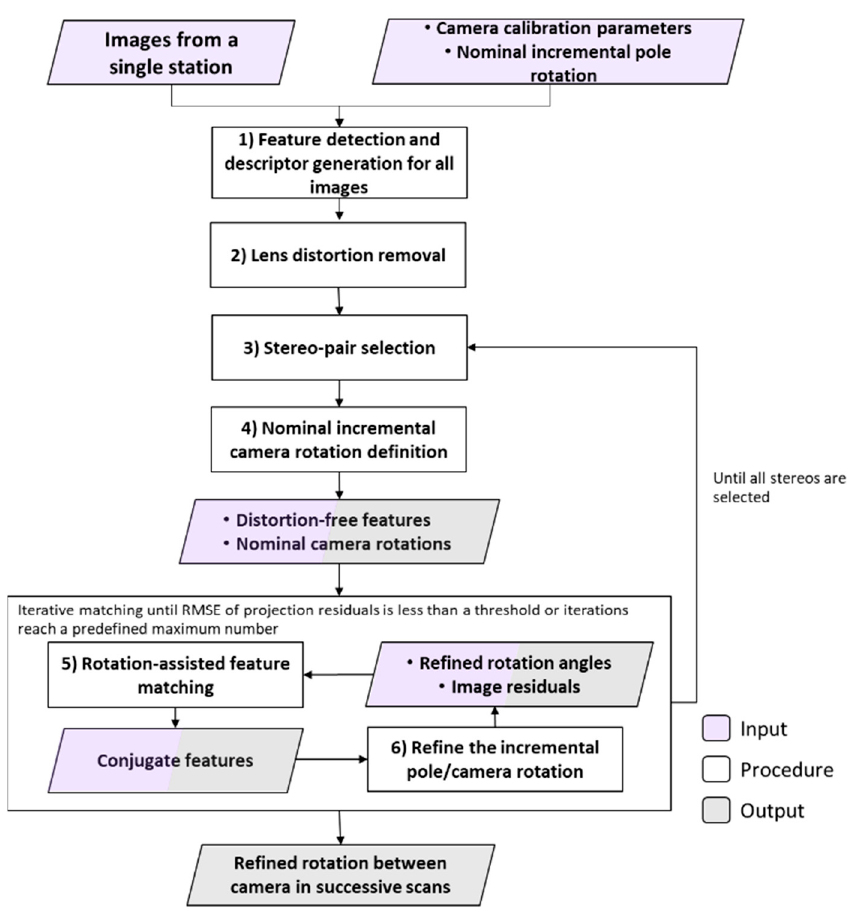
Figure 13. Sample exhaustive matching results with several outliers for a stereo-pair in the US-231 dataset (for a better visualization only 10% of matches are illustrated).